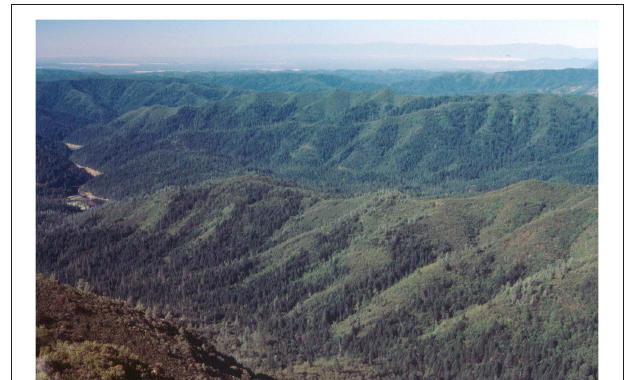
FIGURE 8 | Spatial variation in vegetation patterns related to slope position and fire severity relationships in dry and mesic forests in the Klamath Mountains. Topography creates contrasting conditions in fire behavior and effects; the upper third of slopes, drier aspects, and ridgetops tended to experience higher proportions of high severity fire, while valley bottoms, cooler aspects, and lower slope positions experience the lowest (Photo: Carl